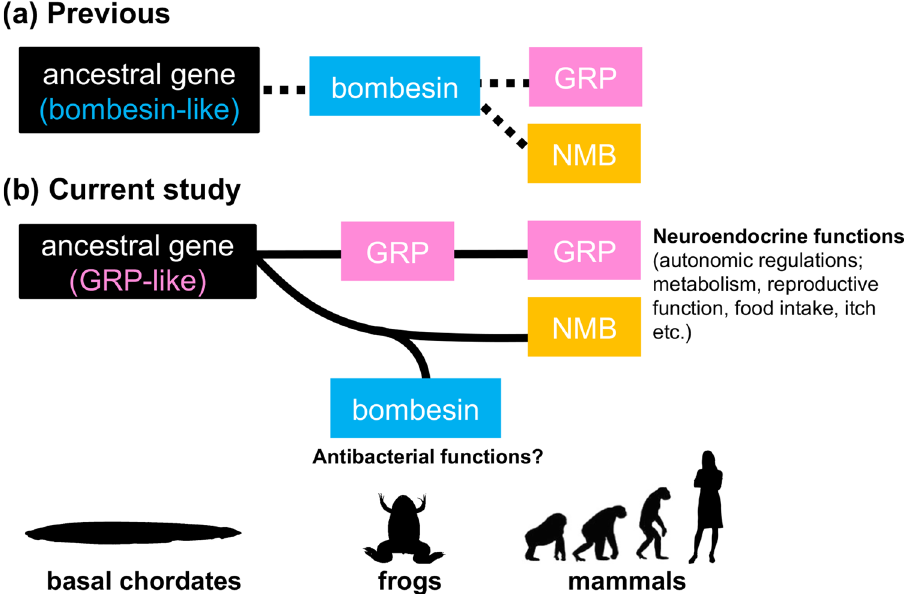
Figure 7. The evolutionary lineage of the gastrin-releasing peptide (GRP)/bombesin. ( a ) Previous studies suggested that GRP (pink box) and neuromedin B (NMB, yellow box) should be considered as the mammalian equivalents of bombesin (blue box). The peptide like bombesin (black box) was thought to be an ancestral form of the bombesin-like family peptides. ( b ) Our current study demonstrates that GRP is not a mammalian orthologue of bombesin and also that, whereas the GRP system is widely conserved among vertebrates, the NMB/bombesin system has diversified in certain lineages, in particular in frog species. The ancestral peptide (black box) is considered to be similar to GRP from the research of the basal chordate amphioxus 36